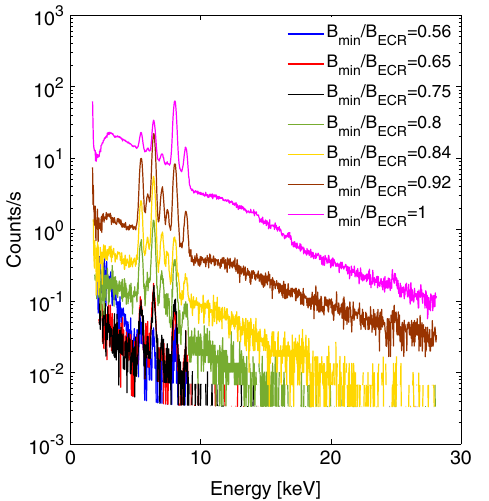
FIG. 9. X-ray spectra as a function of B 1 . 5 × 10 − 4 mbar.